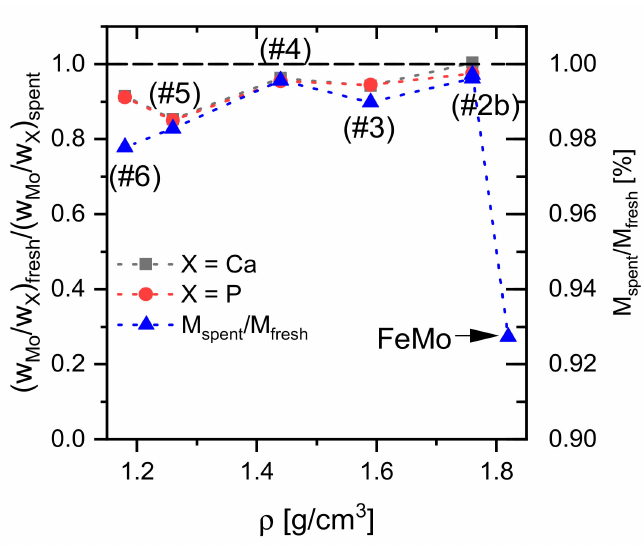
Figure 51. Ratio of Mo to Ca and P (three pellets combined and measured for each sample) and measured mass loss (four pellets combined and measured for each sample) after 118.5 h at 350 ◦ C, 3000 NmL/min, 5 vol.% MeOH, and 10 vol.% O 2 in N 2 (<15% conversion estimated) compared to the fresh samples. Reproduced from [112] with permission from the Royal Society of